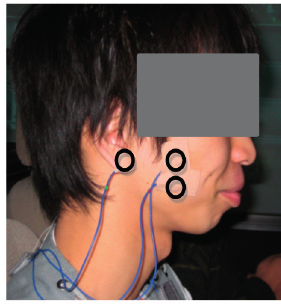
Figure 4. Right side of a participant’s head, showing the reference electrode attached to the ear lobe, and paired electrodes pasted on the right masseter